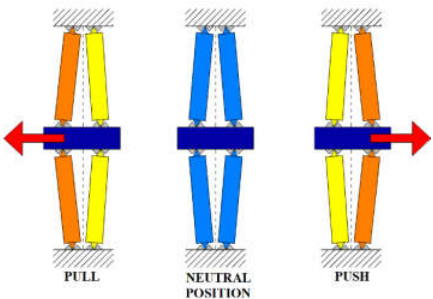
Figure 1. Operating principle of an amplified stack actuator with a diamond structure [14].